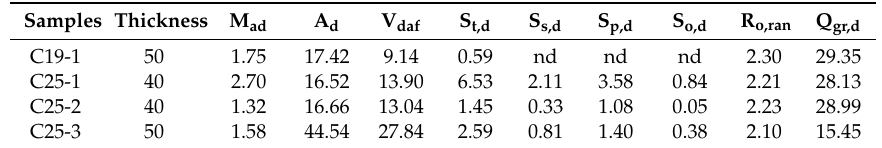
Table 1. Bench thickness (cm), proximate analysis (%), vitrinite random reflectance (%), and gross calorific values (MJ/kg) of coal benches from the Shiping mine.